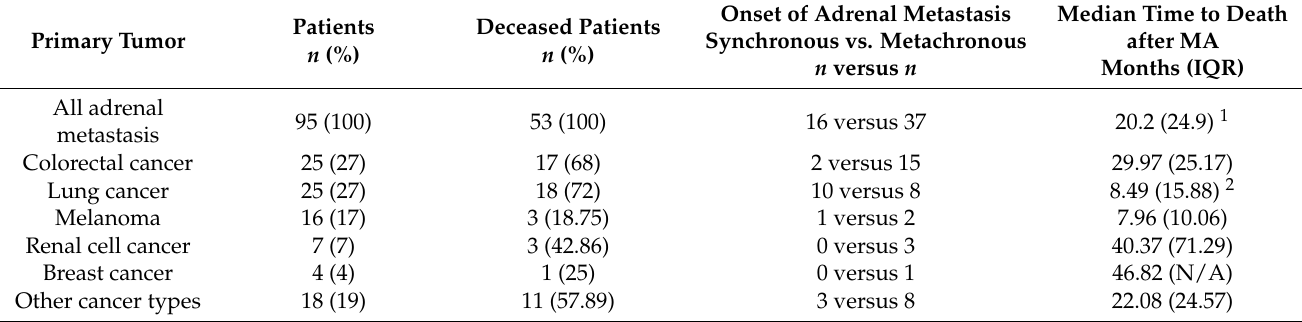
Table 5. Mortality rate and median time to death after metastatic adrenalectomy per tumor